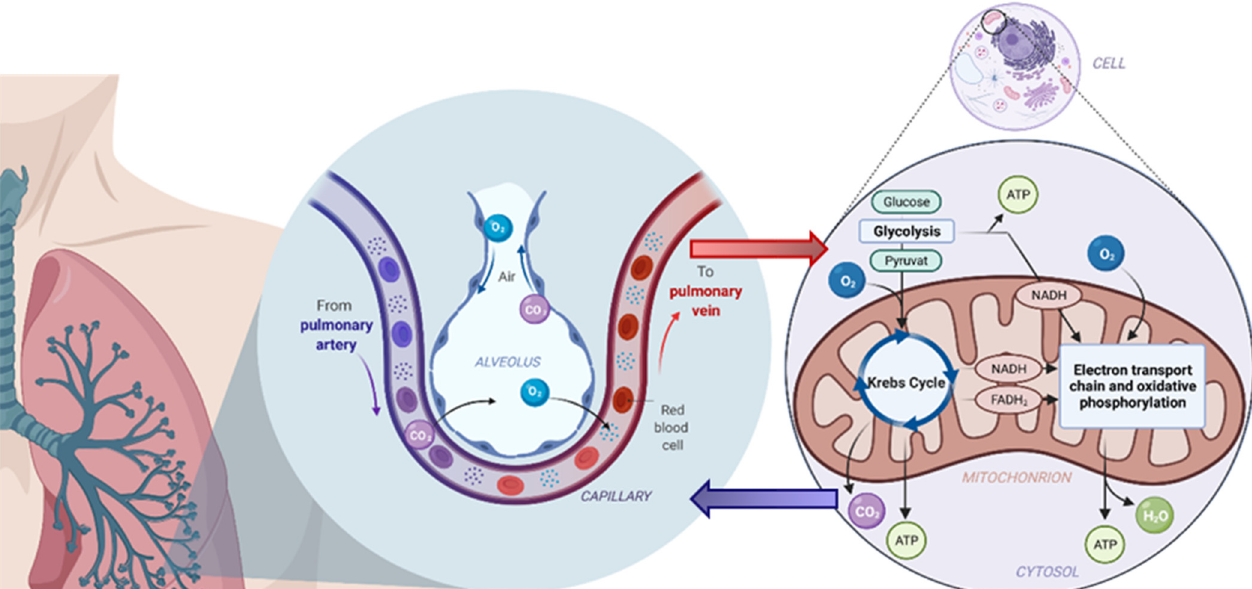
Figure 1. Exchange of respiratory gases—oxygen (O 2 ) and carbon dioxide (CO 2 )—within the alveoli during aerobic cell respiration; the process of aerobic cell respiration and CO 2 production is depicted on the right: pyruvate, generated from glycolysis of glucose, and O 2 enter the Krebs cycle to form CO 2 and produce the energy-intermediate adenosine triphosphate (ATP), as well as the nicotinamide adenine dinucleotide anion (NADH) and the hydroquinone form of flavin adenine dinucleotide (FADH 2 ). During oxidative phosphorylation, electrons are transferred from NADH and FADH 2 to O 2 by a series of electron carriers to form ATP and water (H 2 O). Created with BioRender.com.